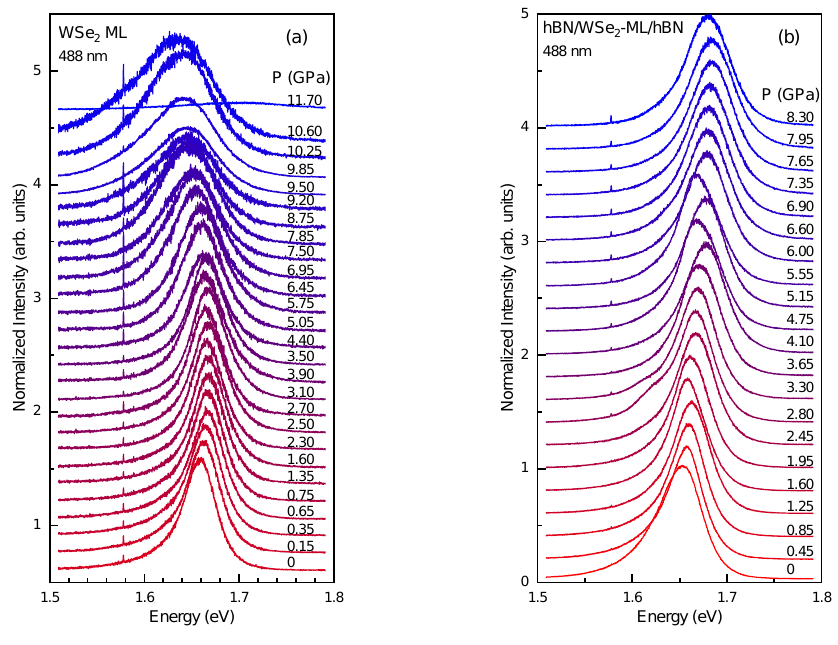
Figure 2: Normalized PL spectra measured at room temperature and as a function of pressure with 488-nm excitation (a) for the bare WSe 2 ML and (b) for the hBN/WSe 2 -ML/hBN vdW heterostructure. The sharp line at 1.58 eV corresponds to the spurious signal from the 785 nm laser.